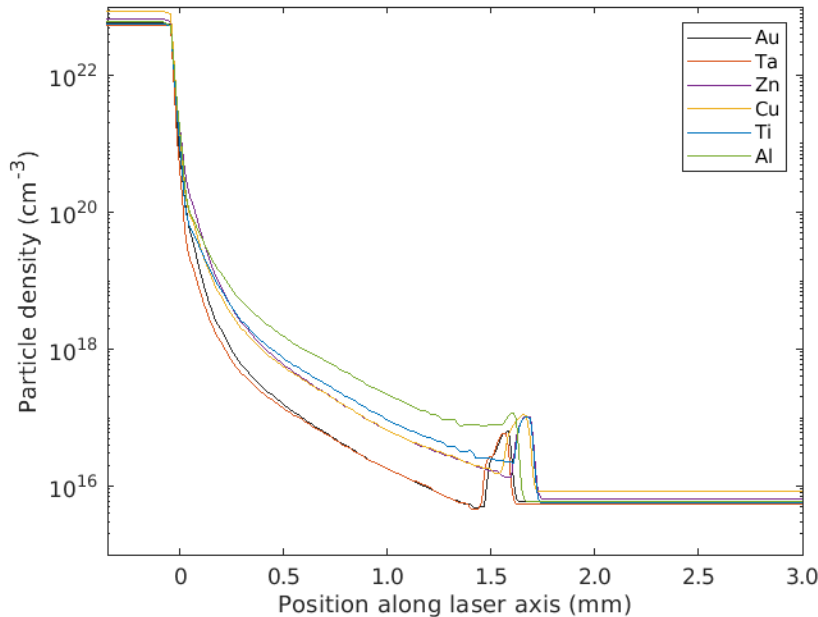
Figure 9. The spatial distribution of the particle density of plasma plumes from six different materials, 25 ns after the laser pulse. The laser fluence was 100.5 J cm − 2 and the laser focus was 100 µ